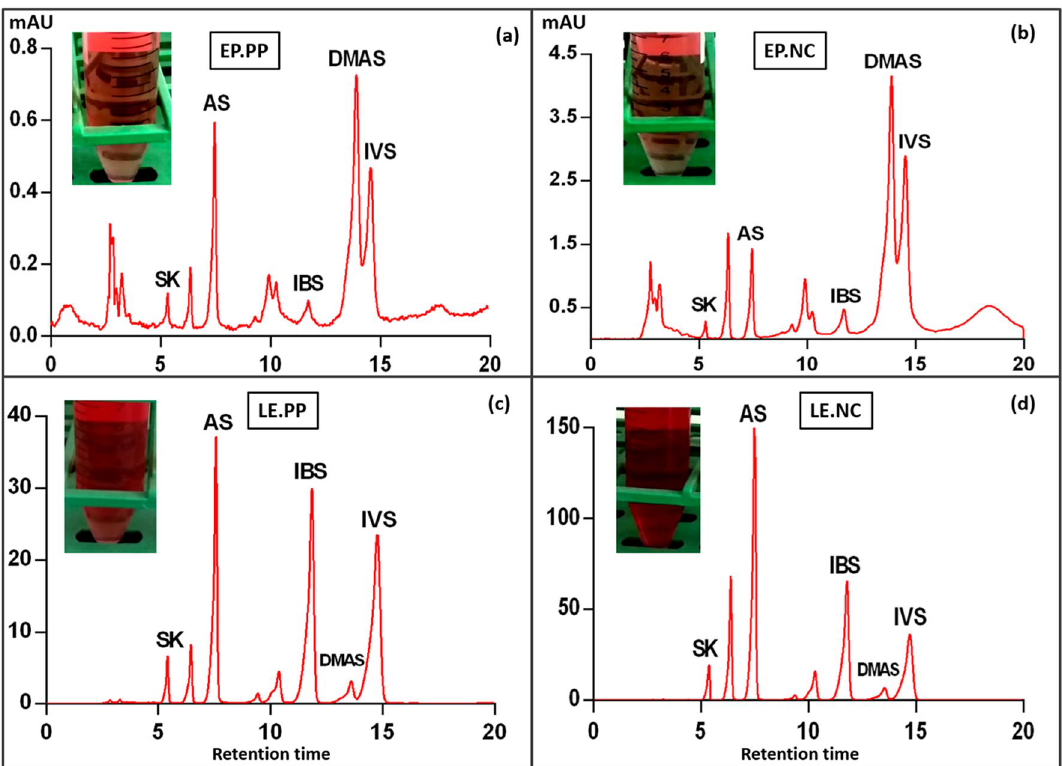
Figure 1. Images and chromatograms representing qualitative and quantitative variation of SK and its derivatives production in root periderm extracts. Chromatograms of root extracts of E. plantagenium (EP) and L.erythrorhizon (LE) specimens grown in Peat potting artificial soil (a) EP.PP, (c) LE.PP; and Natural campus soil (b) EP.NC, (d) LE.NC. Resulting peaks correspond to shikonin (SK), acetylshikonin (AS); isobutylshikonin (IBS); β, β-dimethylacrylshikonin (DMAS); and isovalerylshikonin (IVS). Chromatogram for each sample represents a composite sample of 3–4 individual plants. Figure represents only one replicate for each sample while the rest of the two replicates for each sample with standard chromatogram are provided in Fig.